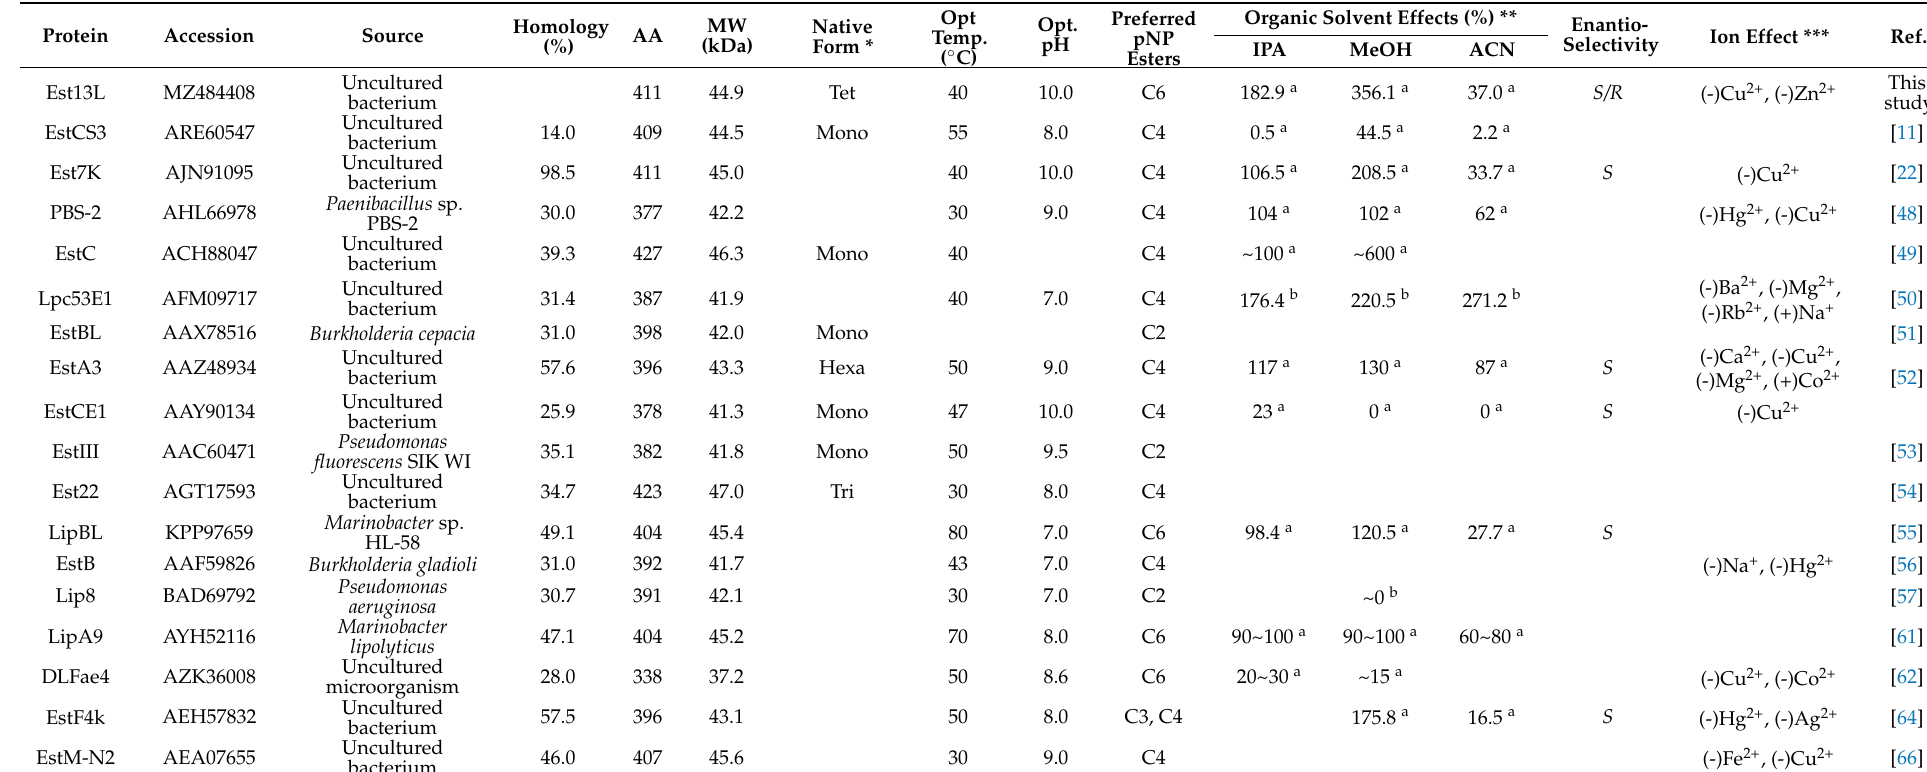
Table 4. Comparison of Est13L and other family VIII